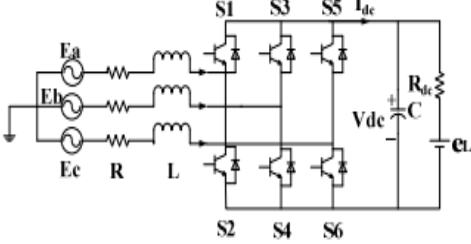
Figure 3. A three phase PWM rectifier [30].